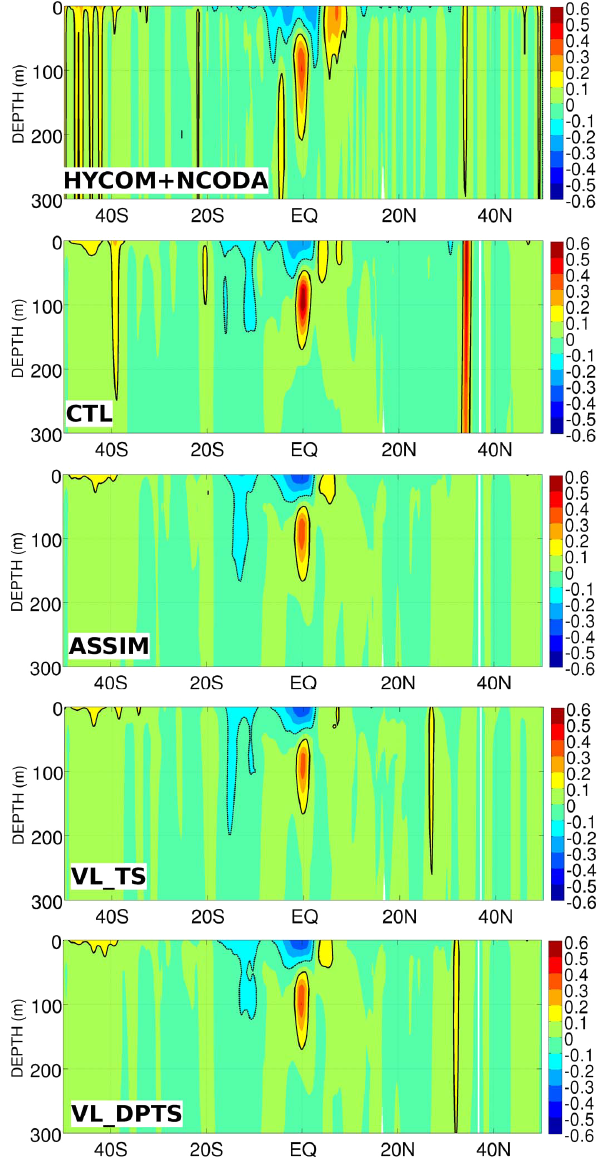
Figure 13. Zonal velocity fields (ms − 1 ) in the upper 300m along 25 ◦ W of the HYCOM + NCODA analysis, the CTL run and the prior state of the ASSIM, VL_TS and VL_DPTS runs from 1 Jan- uary 2010 to 31 December 2012. The black solid and black dashed lines denote the contours of 0.1ms − 1 and − 0 . 1ms − 1 ,